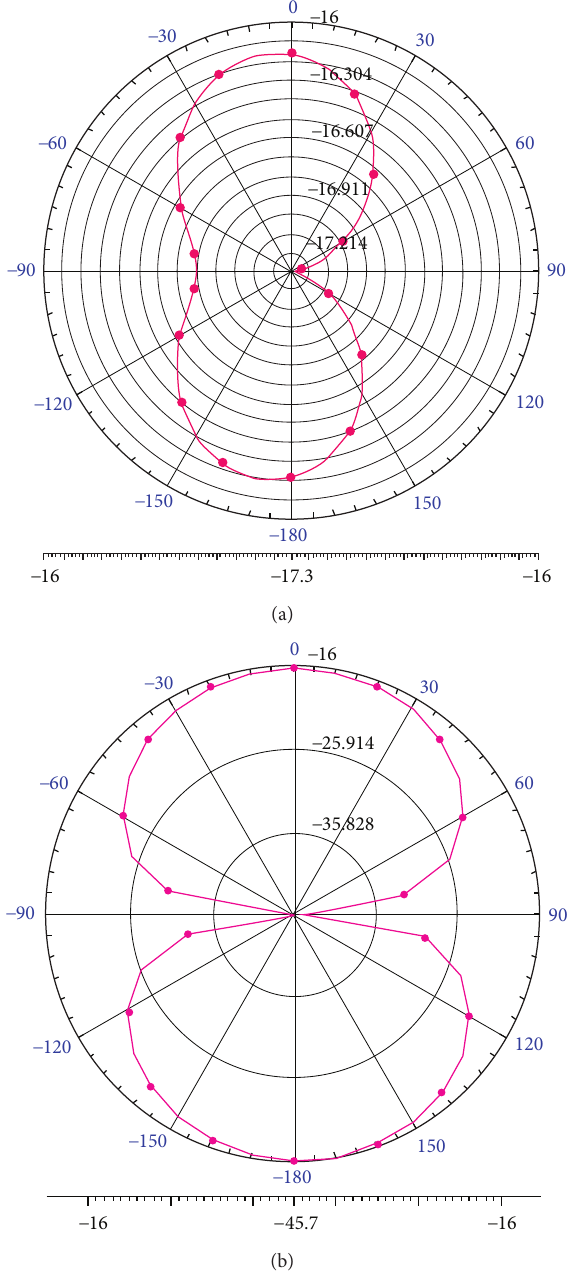
F 11: Simulated far-�eld radiation patterns (a) -plane of the MEMS-MTM antenna at a frequency of 8.65GHz. 𝐻𝐻